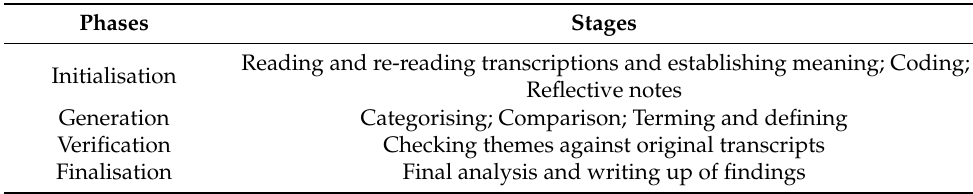
Table 3. Summary of phases and stages of theme development used in the